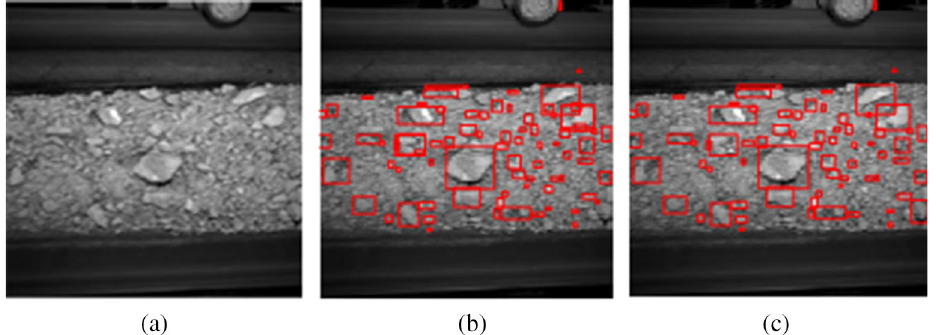
Figure 6. Selective search results. ( a ) Original image. ( b ) Selective search. ( c ) Repetition